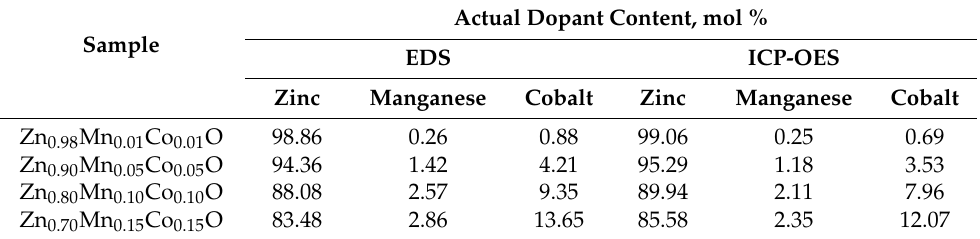
Table 5. Results of the analysis of the chemical composition of Zn (1 − x − y) Mn x Co y O samples. Actual Dopant Content, mol % Sample